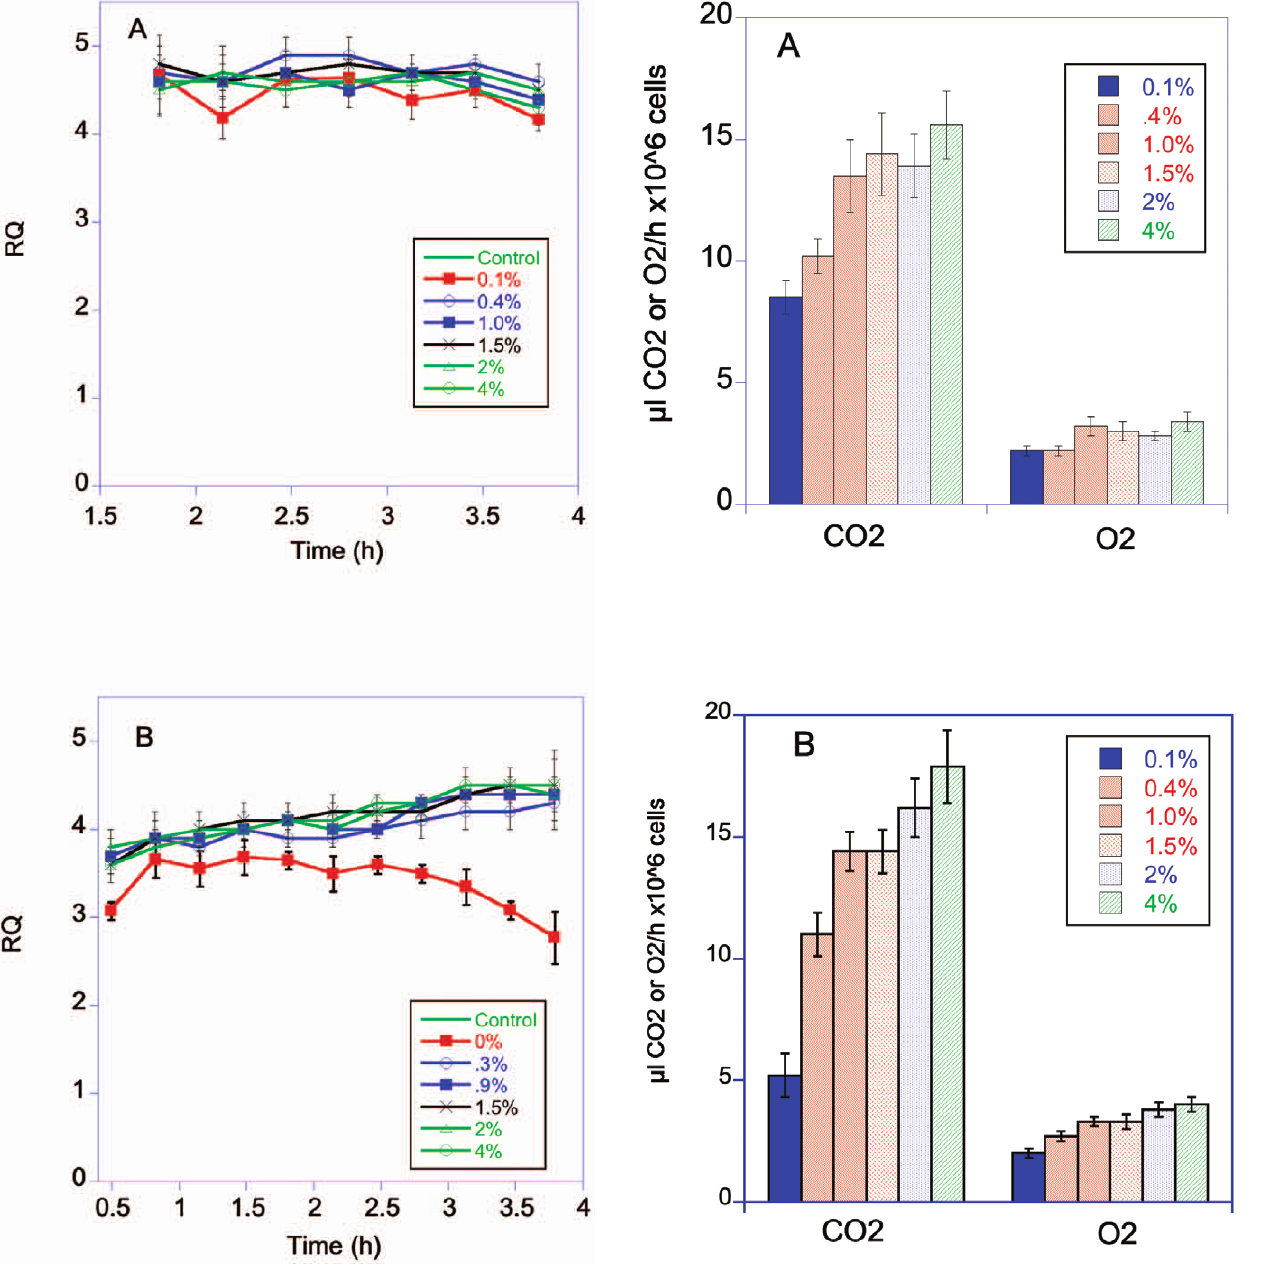
Figure 5. RQ of BY (4A) and RM (4B) grown in YP with a starting concentration of 0.1 to 4% dextrose.